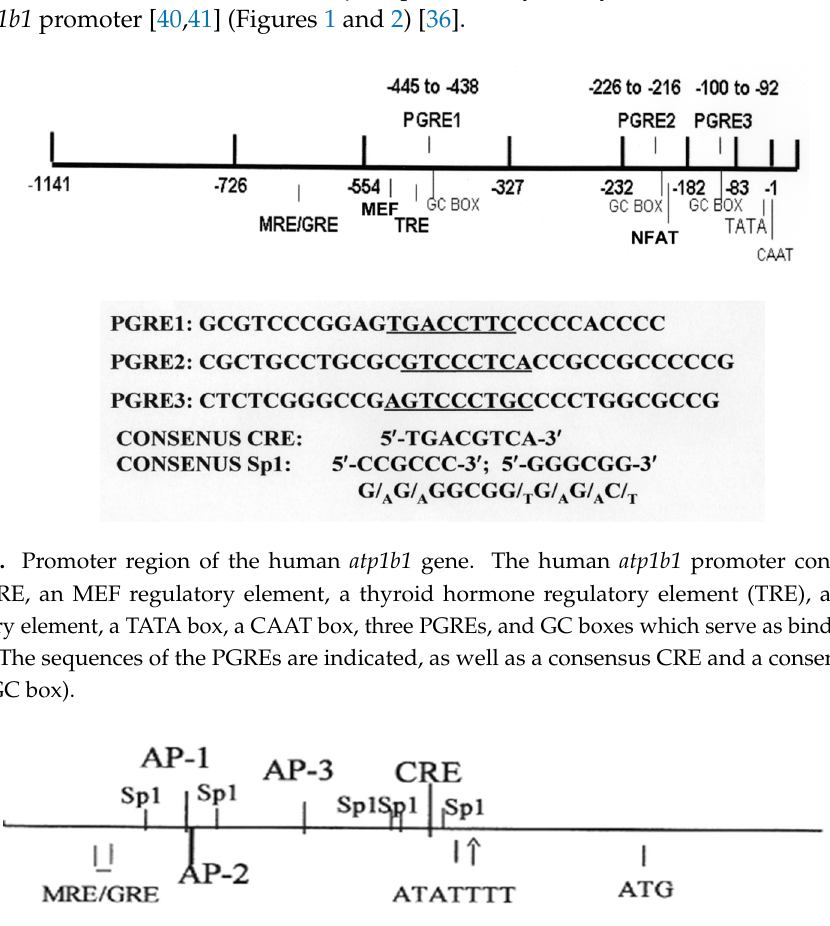
Figure 2. Structure of the human atp1a1 promoter. The human atp1a1 promoter has an MRE/GRE; AP-1, AP-2, and AP-3 sites; a CRE; and five Sp1 sites (or GC boxes).